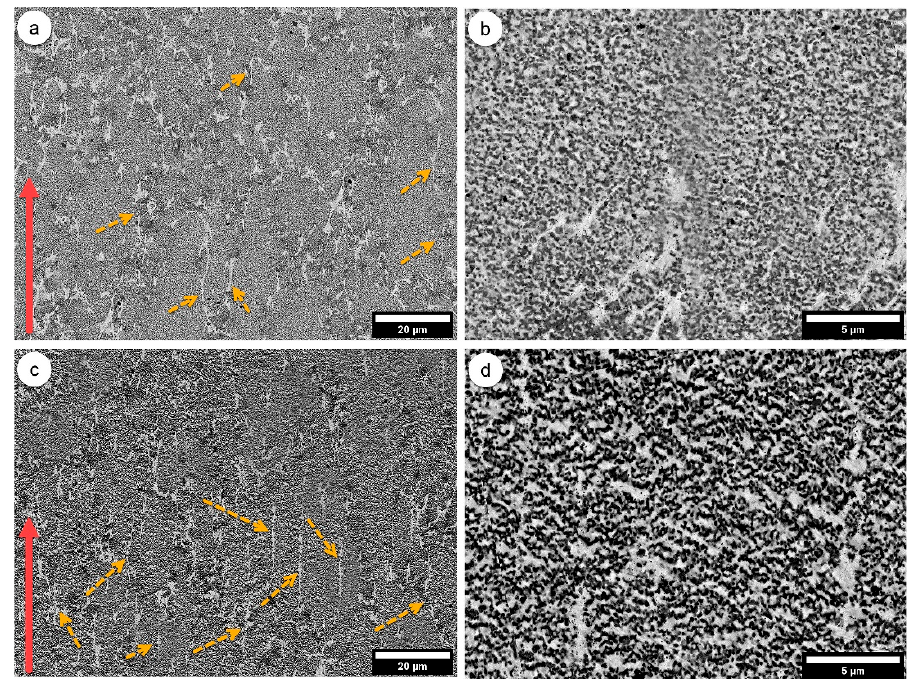
Figure 4. Microstructures of the edges of the samples: ( a , b ) FSPS_1 and ( c , d ) FSPS_2. The red arrow indicates the direction of applied electrical current and the yellow ones signify the Cu-rich layers that are oriented in the direction of applied current.